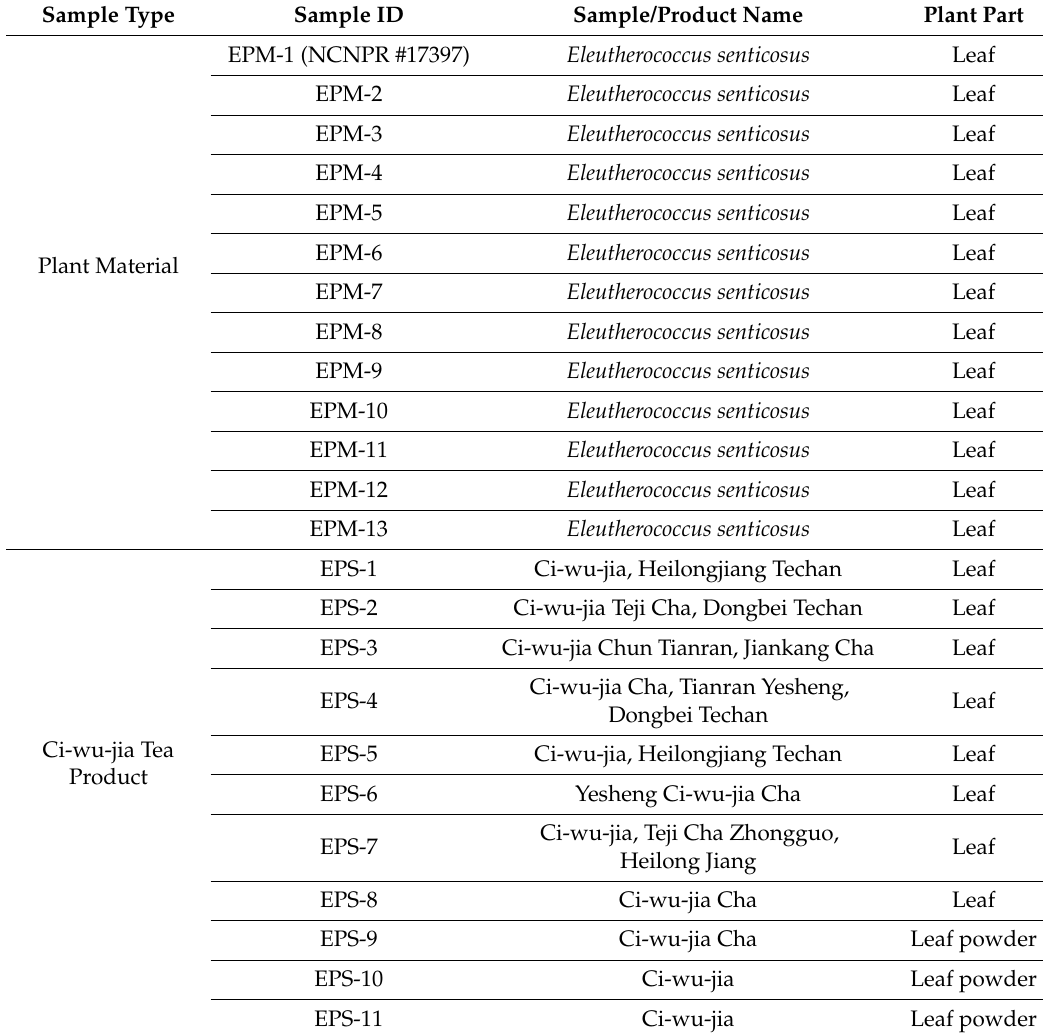
Table 2. Eleutherococcus senticosus plant samples and Ci-wu-jia tea products used in this